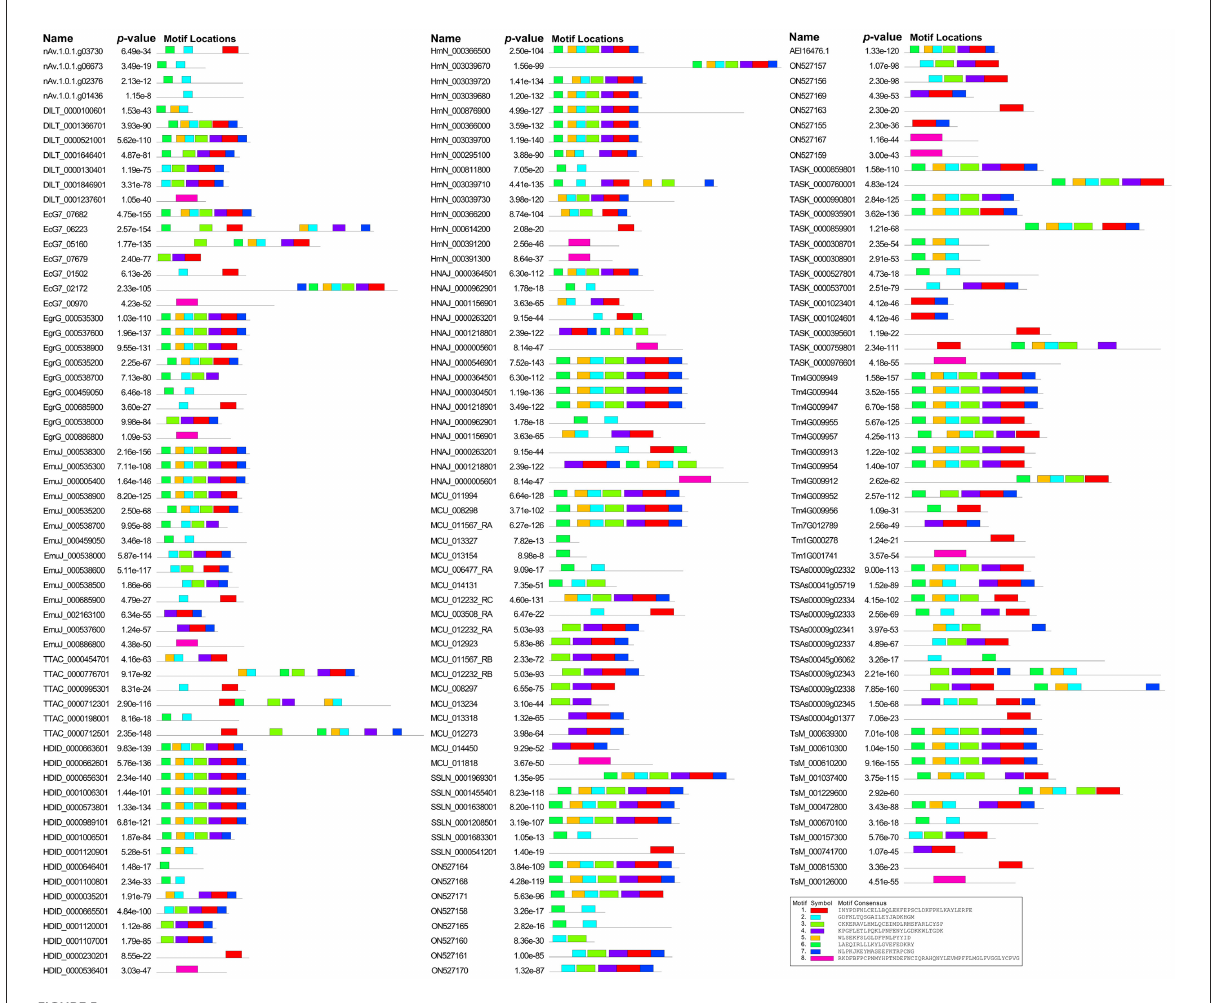
FIGURE5 Conserved motifs of GST sequence motifs in medical